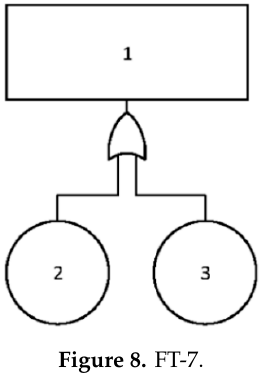
Figure 8. Figure 8. FT-7.